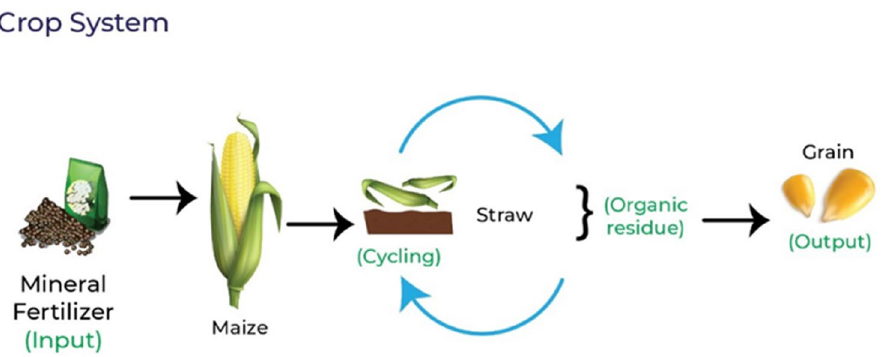
Figure 3. Representation of inputs and outputs of nitrogen and organic residues generated in the crop system.